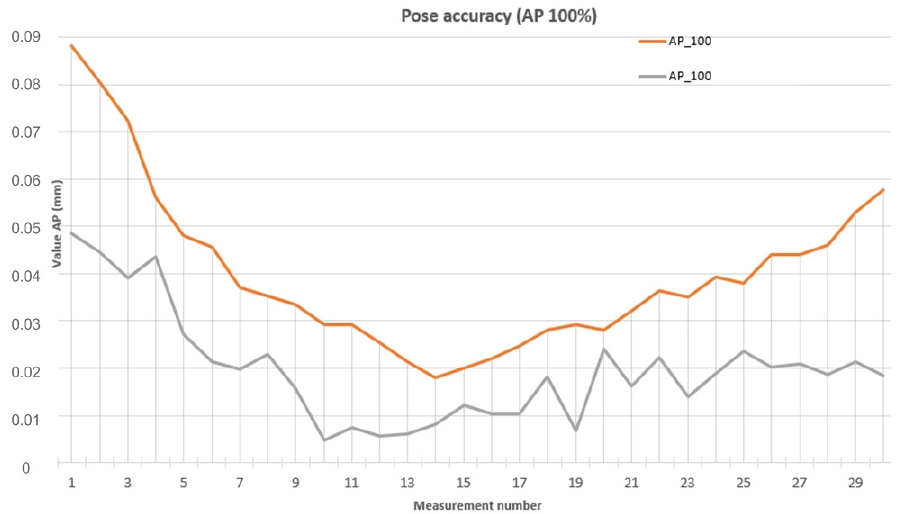
Figure 6. Plotted comparison of AP under the full load.